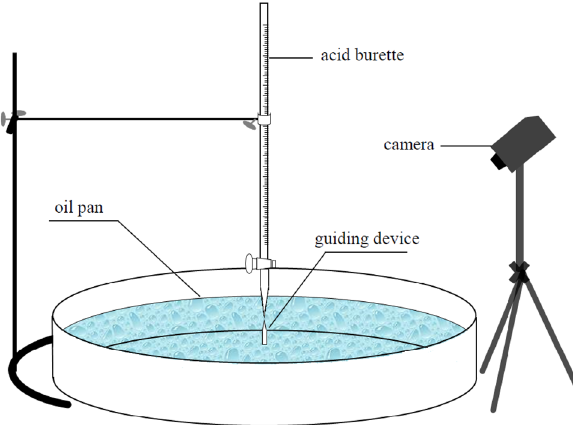
Figure 1. Schematic diagram of spreading experimental device.